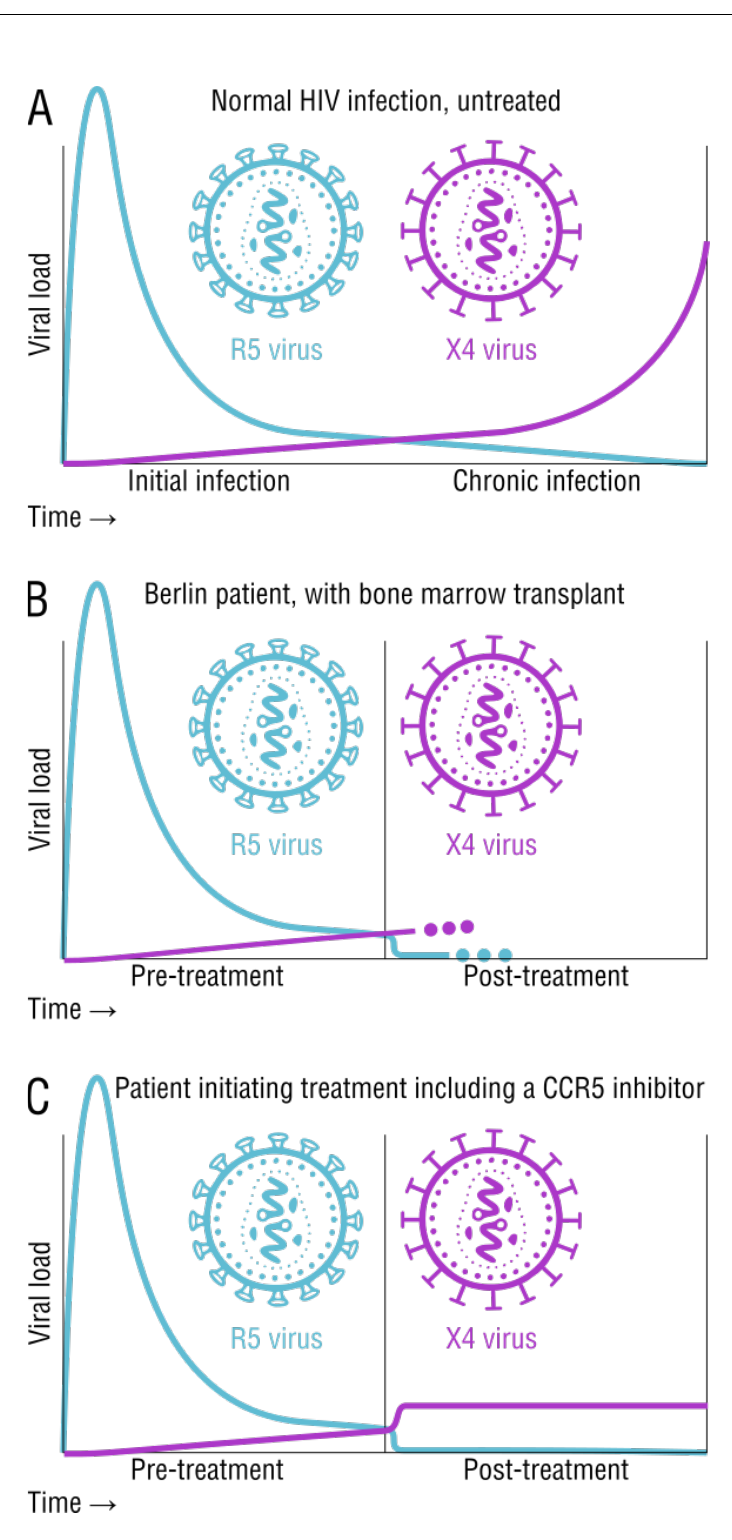
Figure 2. The outcome of tropic switching over time due to HIV mutation. ( A ). The normal pattern of HIV infection starts with becoming infected with the R5 variant which attacks the CCR5 receptor. The virus then mutates and becomes X4-tropic, gaining entry via the CXCR4 receptor, also correlating with the progression to AIDS. ( B ). The Berlin patient received a bone marrow transplant from a donor with the CCR5 Δ32/Δ32 mutation, however the patient was cleared of both R5-tropic and X4-tropic HIV, a rare and unusual cure. ( C ). Treatment with CCR5 inhibitors like Maraviroc quickly induces a tropic switch to X4 variants. Viral load remains low due to other components that would be used in combination.